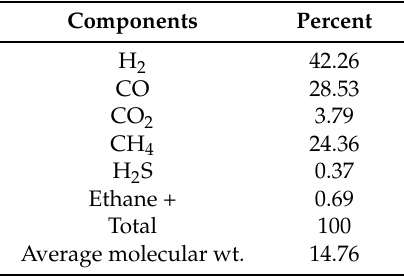
Table 12. Composition of devolatilized products assumed by Gunn and Whitman